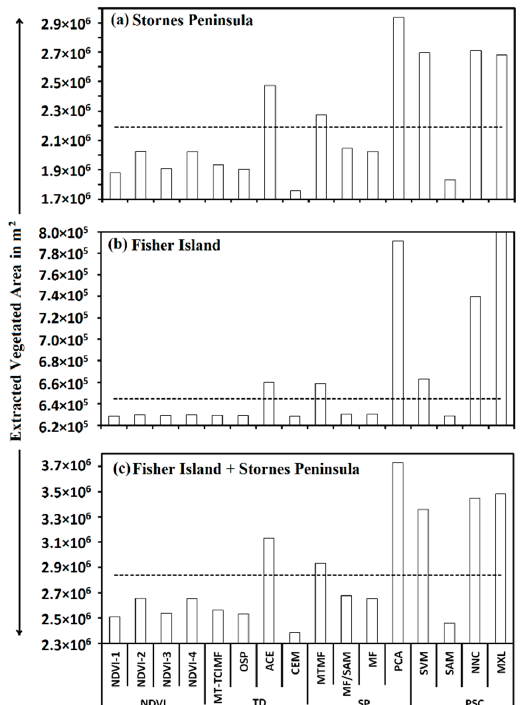
Figure 6. The overall performance trend for all vegetation extraction methods grouped in three approaches [Target detection (TD), Spectral processing approach (SP) and pixel-wise supervised classification approach (PSC)], in terms of extracted vegetation area (m 2 ) of ( a ) Fisher Island) ( b ) Stornes Peninsula and ( c ) Fisher Island + Stornes Peninsula with reference to manual digitization supplemented by ground-truthing. The black dotted line highlights the reference vegetated